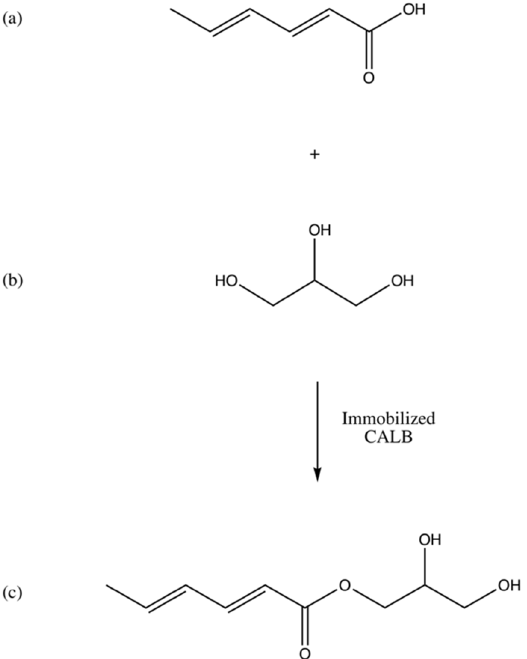
Figure 1. Between sorbic acid and glycerol catalyzed by immobilized lipase B from C. antarctica . ( a ) sorbic acid, ( b ) glycerol, ( c ) glycerol ester of sorbic acid.